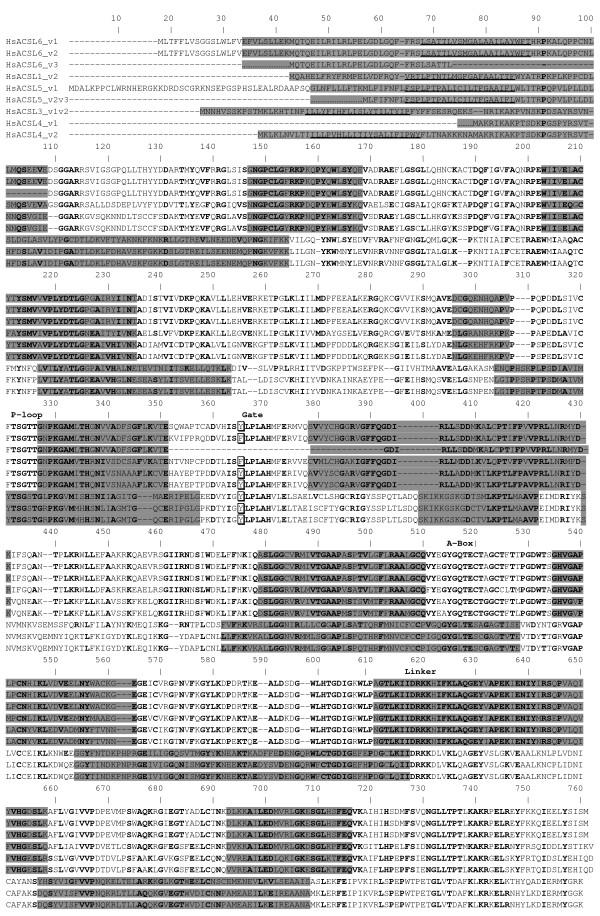
Sequence alignment of the human acyl-CoA synthetases long-chain family members. The succession of clear-shaded blocks overlaid on the alignment represents the exon organization of the respective mRNA. Conserved residues are in bold. Position of the P-loop, Gate, A-box and Linker motifs is indicated. Y and F residues of the two alternative Gate domains are boxed and indicated with a star. Transmembrane spanning segments predicted with the highest score by TopoPrediction, SOSUI and TMHMM are underlined. For clarity, ACSL3 variant 1 and 2, and ACSL5 variant 2 and 3, which encode the same isoform, are annotated as ACSL3_v1v2 and ACSL5_v2v3, respectively. Alignment was performed with MUTALIN [14]. Protein length (residues): ACSL1_v1, 698; ACSL1_v2, 698; ACS3_v1v2, 720; ACSL4_v1, 670; ACSL4_v2, 711; ACSL5_v1, 739; ACSL5_v2v3, 683; ACSL6_v1, 722; ACSL6_v2, 722; ACSL6_v3, 622. GenBank accessions numbers are given in Table 2.